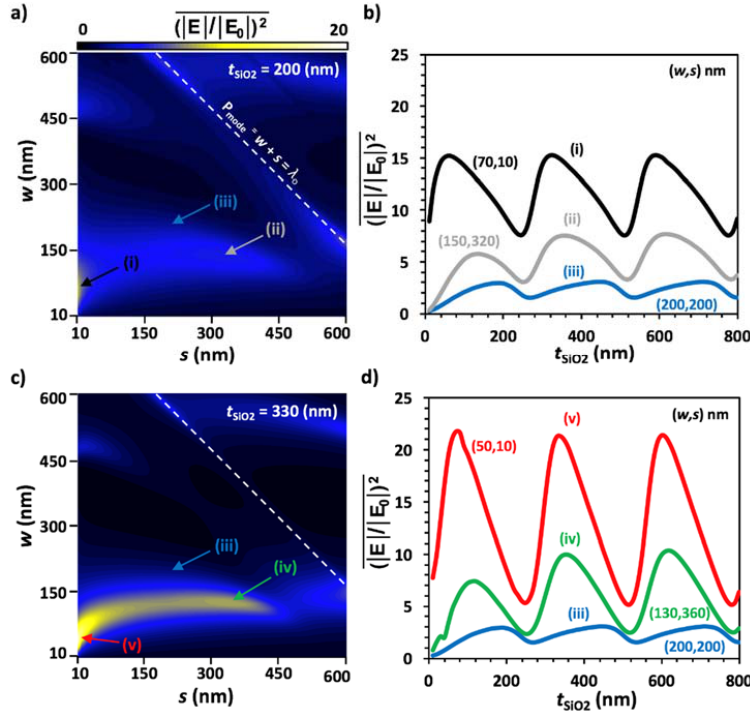
Figure 3. ( a ) Color plot of line average enhancement versus s and w with t SiO ₂ = 200 nm. The arrows point to (i) optimized geometry values w = 70 nm and s = 10 nm, (ii) secondary peak geometry values w = 150 nm and s = 320 nm, and (iii) standard fabrication geometries w = 200 nm and s = 200 nm. The white dotted line indicates a resonant mode corresponding to the period of the structure at 785 nm, the same as λ 0 ; ( b ) Sweep of line average enhancement versus t SiO ₂ at (i), (ii), and (iii); ( c ) Second iteration of ( a ) with maximum t SiO ₂ = 330 nm found from ( b ). The arrows point to (v) the optimized enhancement value occurring at w = 50 nm and s = 10 nm, (iv) secondary peak geometry values w = 130 nm and s = 360 nm, and (iii) standard fabrication geometries w = 200 nm and s = 200 nm; ( d ) Second sweep of line average enhancement versus t SiO ₂ at (iii), (iv), and (v) to optimize t SiO ₂ . The geometry is optimized at t SiO2 = 50, 330, or 590 nm, w = 50 nm and s = 10 nm; however, a second peak occurs at t SiO ₂ = 630 nm, w = 130 nm and s = 360 nm, which is more easily fabricated.